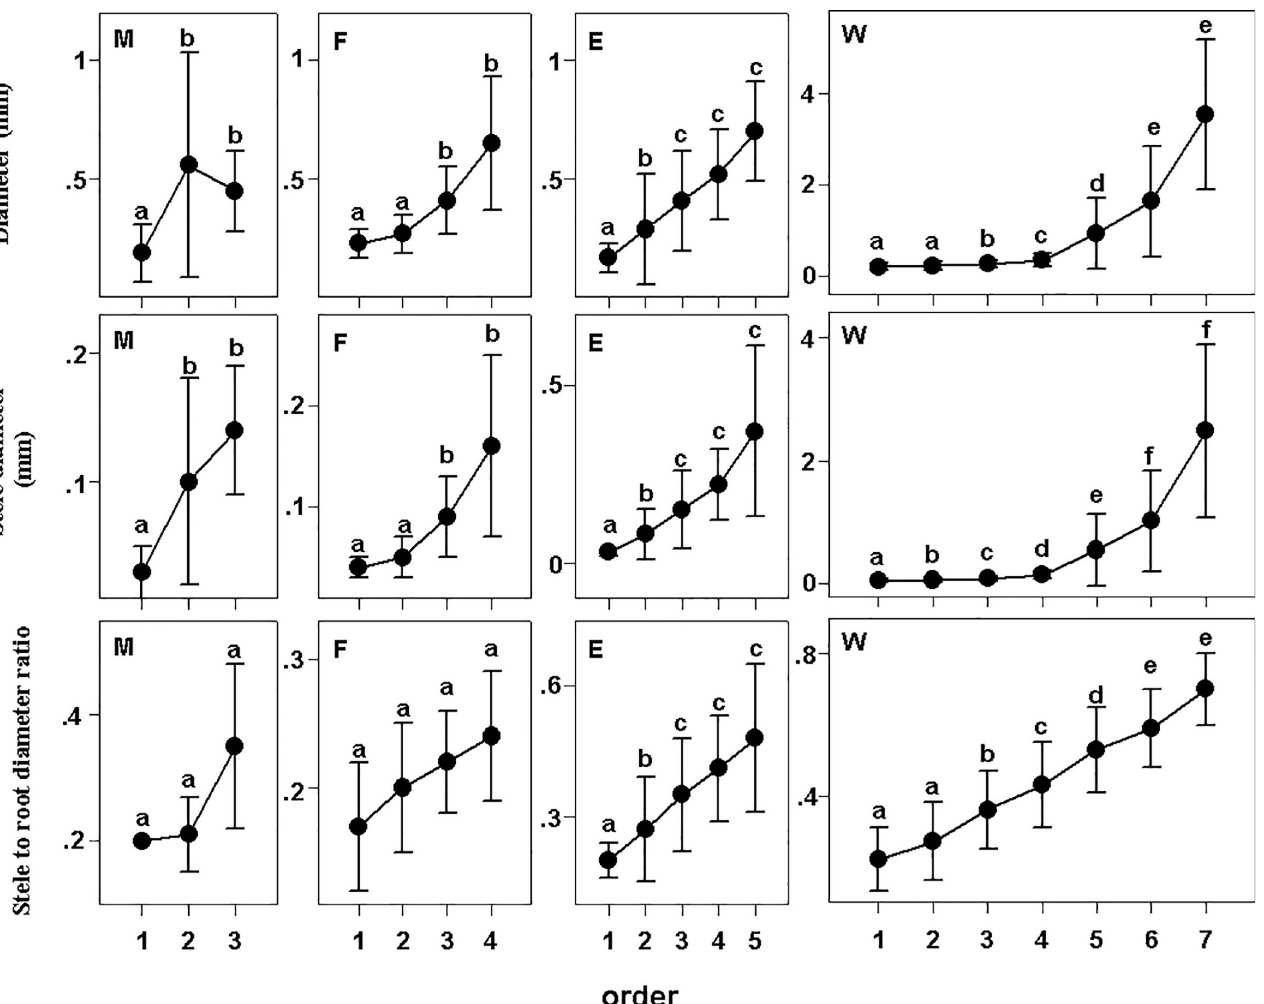
Fig 1. Diameter, stele diameter, xylem cell diameter, and the stele to root diameter ratio in different groups. Different lower-case letters indicate significant differences (P < 0.05) among orders. The error bars represent 1 SD of the mean. M: Monocots; F: Fern; E: Eudicot herbs; W: Woody plants.